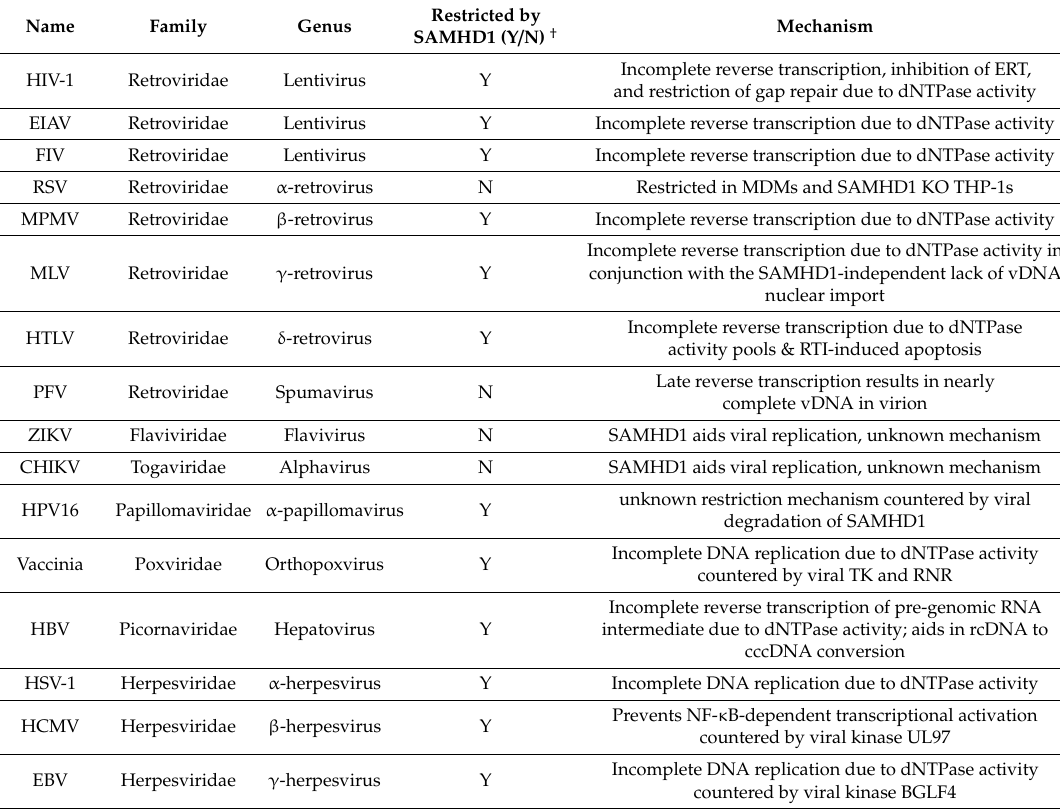
Table 1. Di ff erent restriction mechanisms of SAMHD1 against RNA and DNA